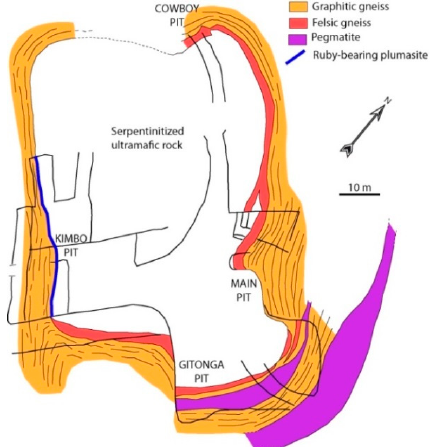
Figure 38. Geological map of the John Saul (now Rockland) mine and its serpentinized ultramafic rock body located in the metamorphic formations of Mgama-Taita, modified after [118]. The